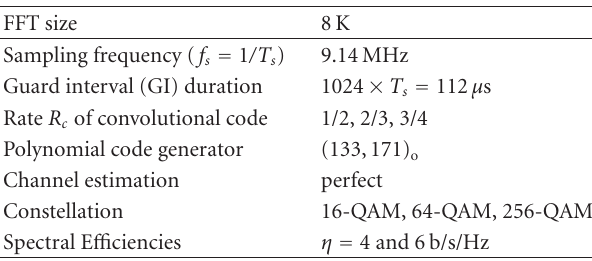
Table 1: Simulations parameters.